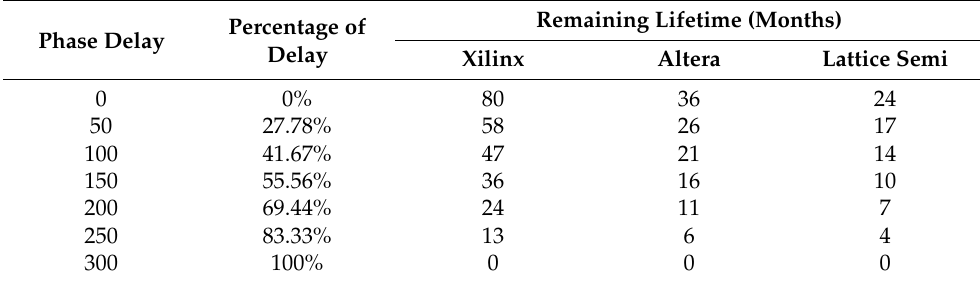
Table 3. Lifetime prediction for Xilinx, Altera, and Lattice Semi FPGAs.